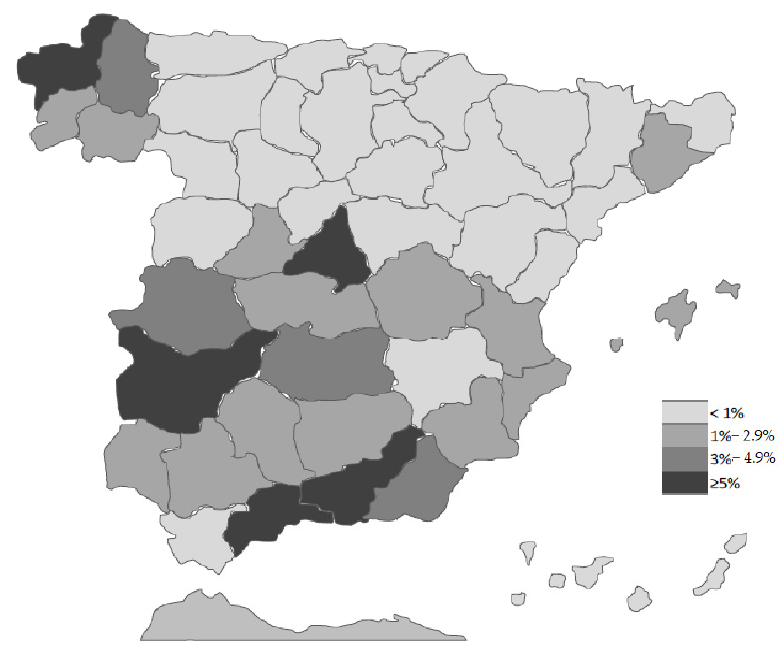
Figure 2. Soldiers surveyed by province of origin (percentage) (N = 10,727).